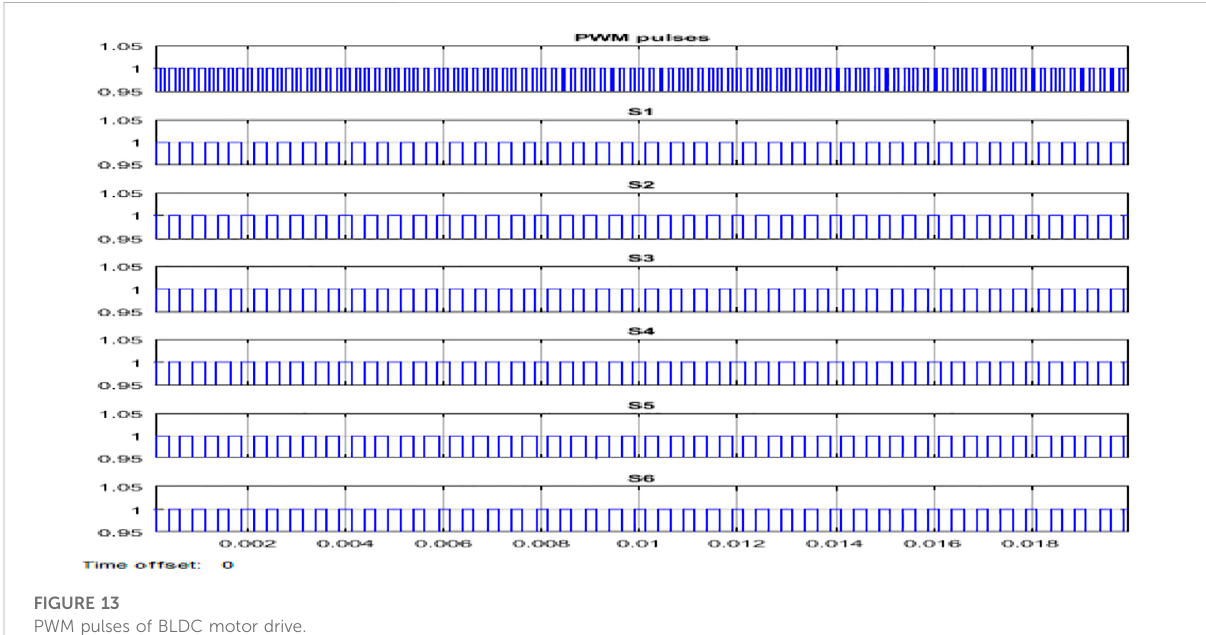
FIGURE 13 PWM pulses of BLDC motor drive.